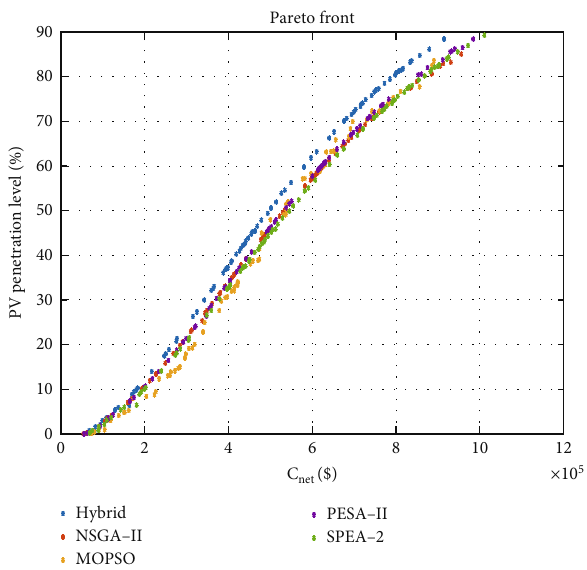
Figure 18: Comparison of Pareto fronts of fi ve MOEAs.